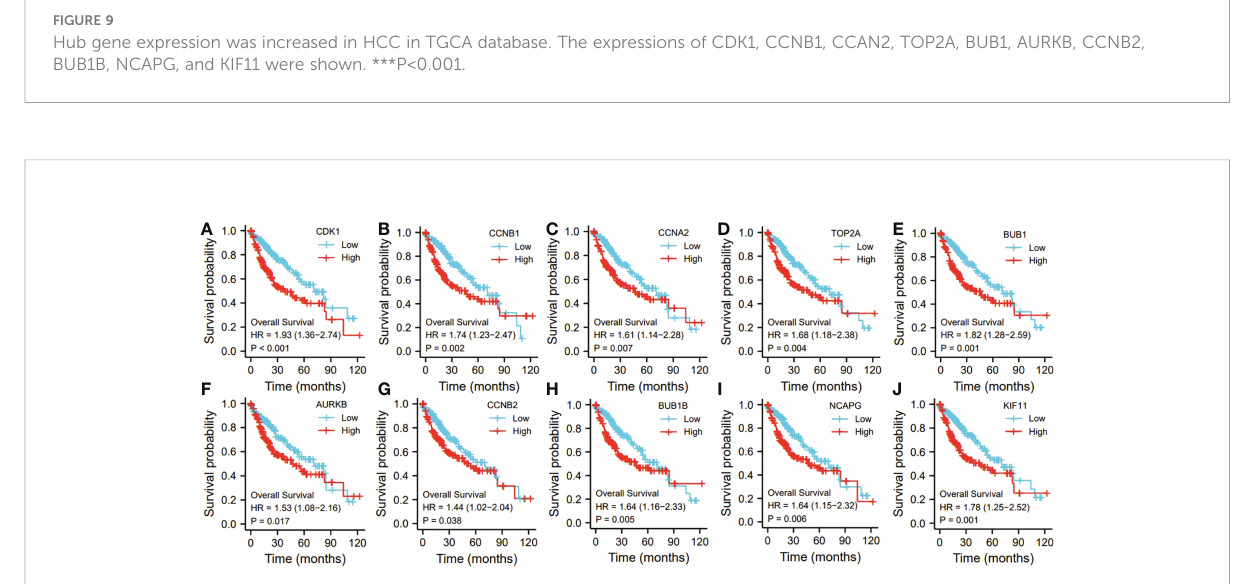
FIGURE 10 The hub gene related to the overall survival (OS) of HCC patients in TGCA database. The expressions of CDK1 (A) . CCNB1 (B) , CCAN2 (C) , TOP2A (D) , BUB1 (E) , AURKB (F) , CCNB2 (G) , BUB1B (H) , NCAPG (I) , and KIF11 (J) were